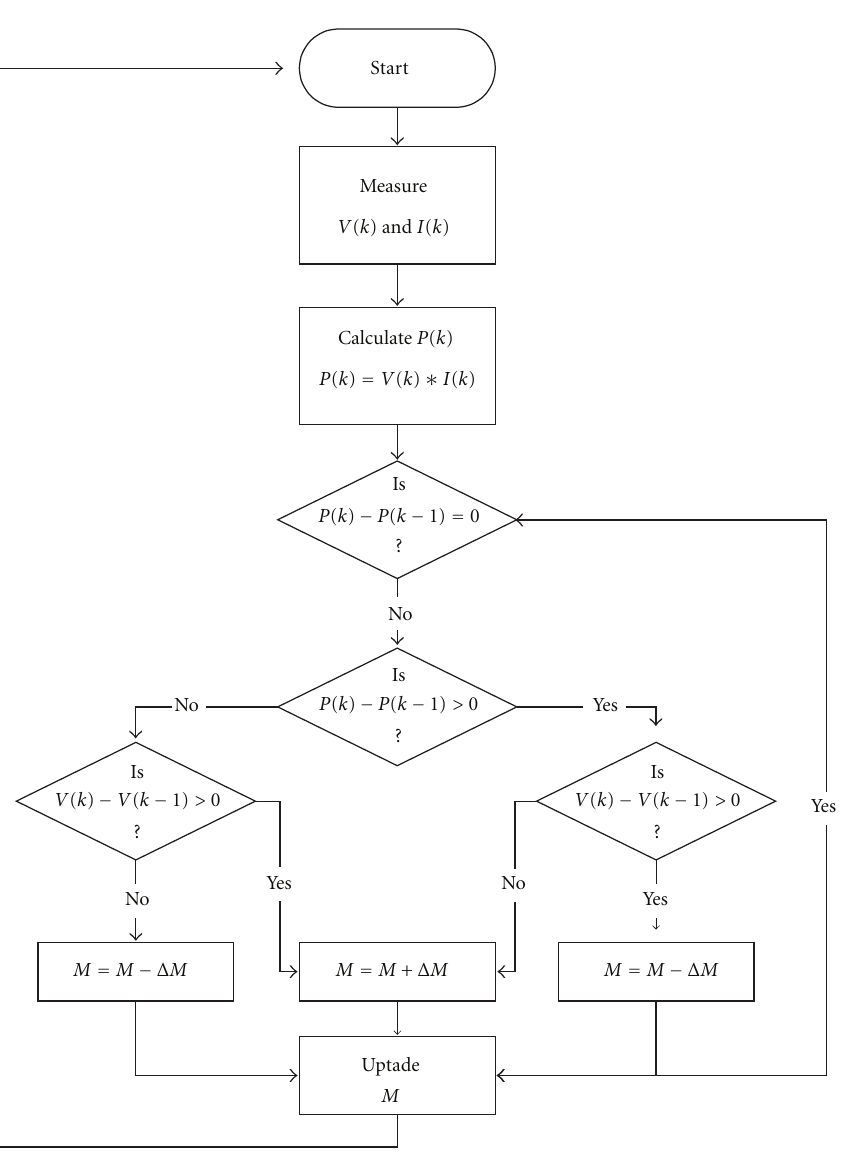
Figure 5: Flowchart of hill-climbing MPPT